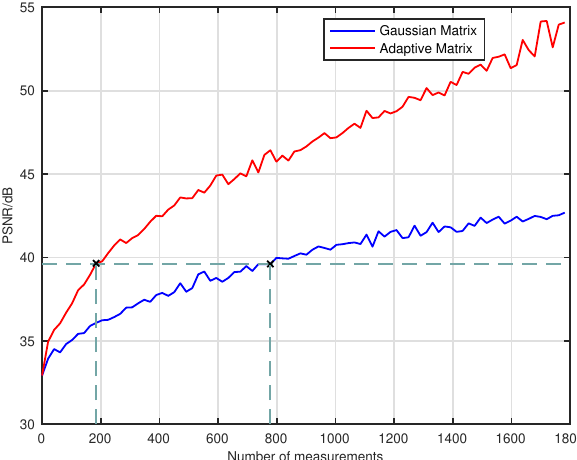
Figure 4. PSNR of image reconstructed with number of measurement time from 0 to 1800 with a step of 20, which measured with the Gaussian random matrix and the adaptive measurement matrix. When the PSNR of both image is 39.6 dB, the image measured with the Gaussian random matrix requires 779 measurements, while the image measured with the adaptive measurement matrix requires only 184 measurements.